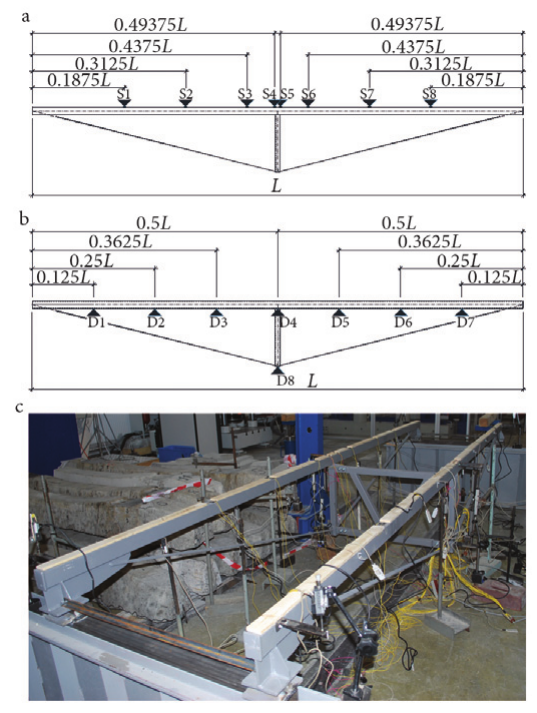
Fig. 2. Test set up: a – arrangement of the strain gauges; b – displacement sensors; c – experimental model in the Lab Table 1. Parameters of the experimental